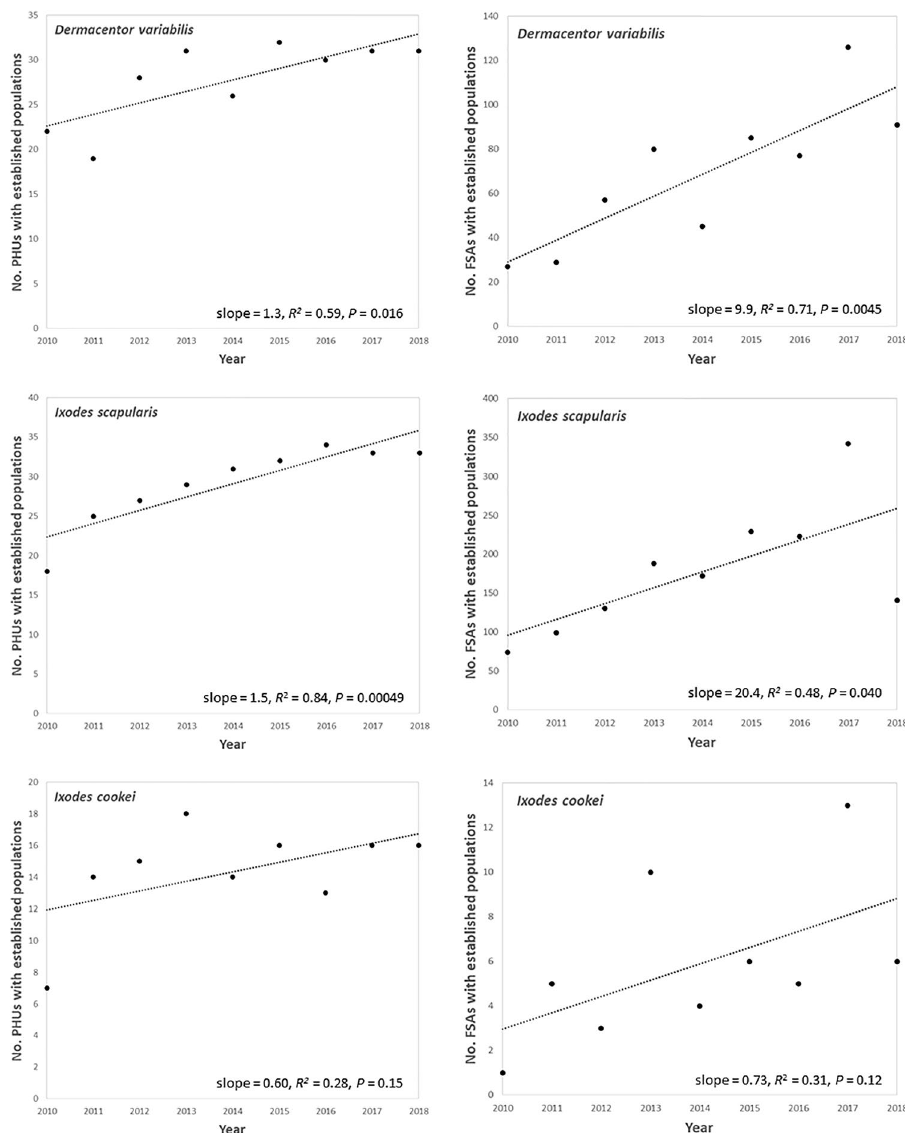
Figure 3. Relationship between Dermacentor variabilis submissions and time by public health unit (PHU, left panel) and Forward Sortation Area (FSA, right panel), compared with Ixodes scapularis (positive control) and Ixodes cookei (negative control): Ontario, Canada